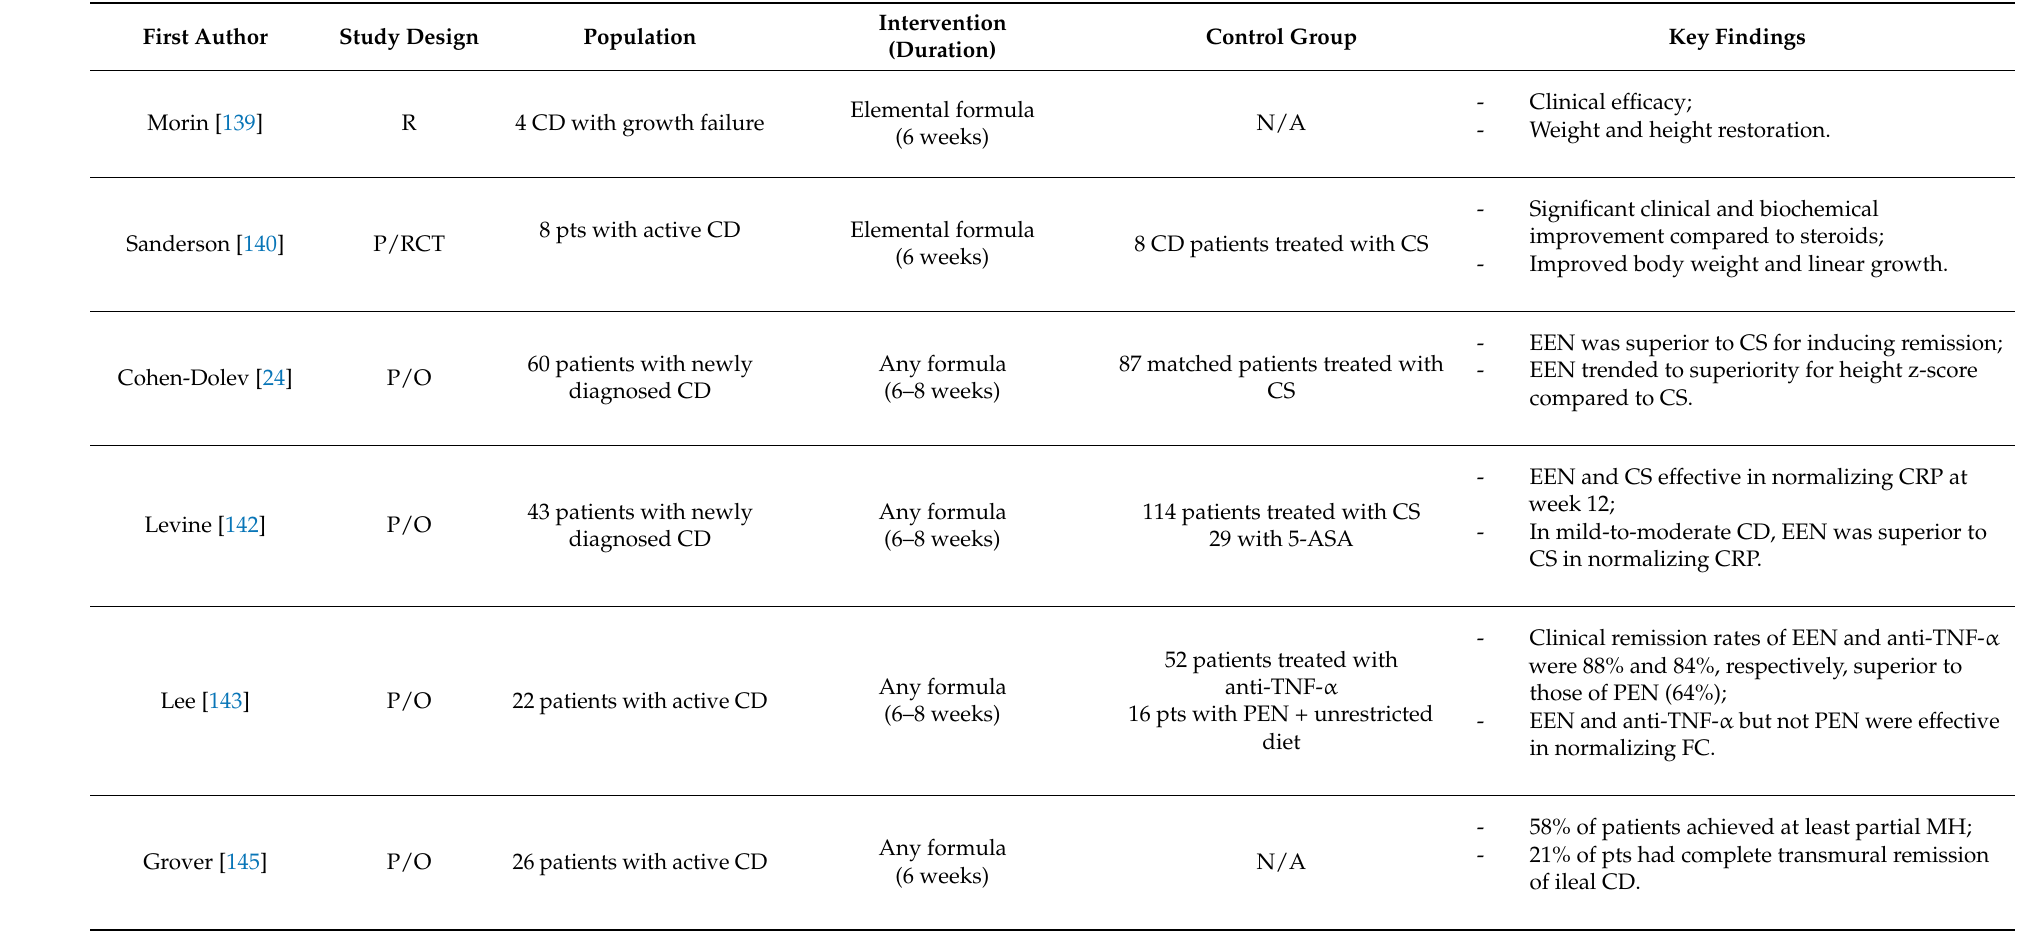
Table 1. Summary of the studies using EEN as nutritional therapy in children with